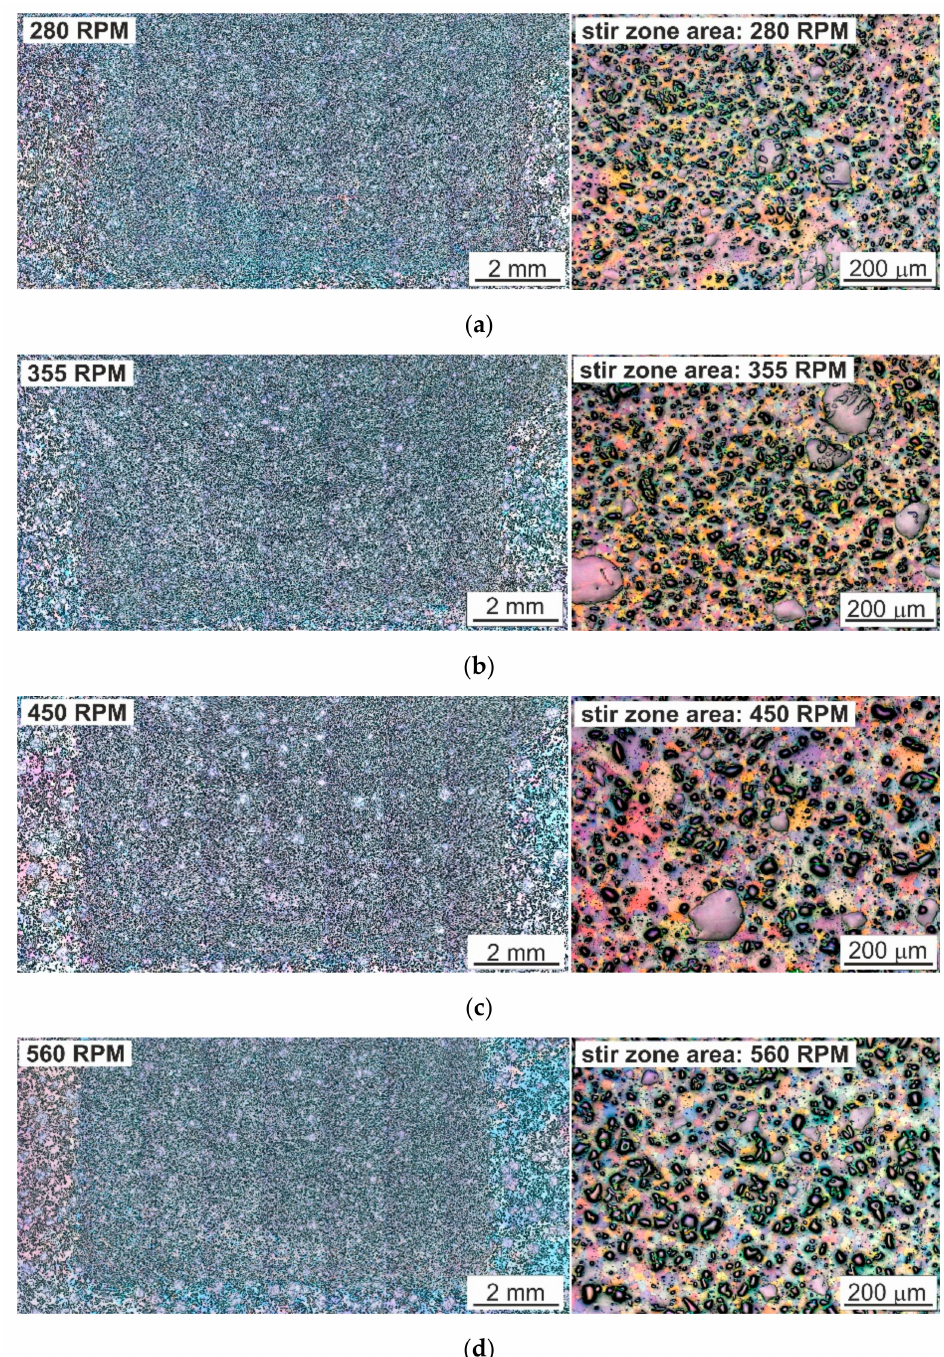
Figure 4. Microstructure of SnSb11Cu6 alloy after FSP with visible unmodified area (left side); photo on the right shows the modified area. ( a ) 280 RPM, ( b ) 355 RPM, ( c ) 450 RPM, ( d ) 560 RPM;